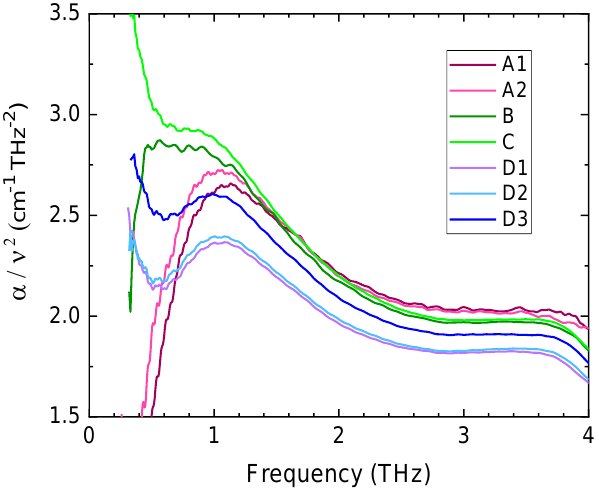
Figure 9. The Boson peak in Spectrosil 2000 silica glass samples.